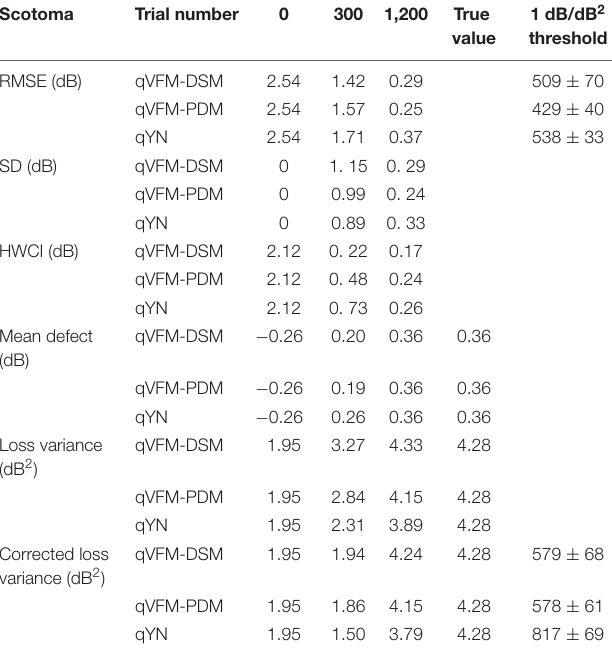
The corresponding true values are listed in the sixth column. Trial numbers needed to achieve 1 dB RMSE and 1 dB 2 within the corrected loss variance are listed with their SD in the last